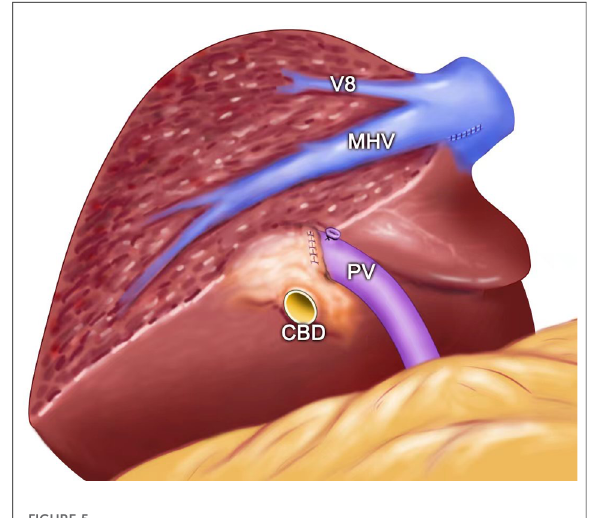
FIGURE 5 The view showing the MHV being exposed after left semi- hepatectomy for intrahepatic stones. MHC, middle hepatic vein; PV, portal vein; V8, vein of segment 8; CBD: common bile